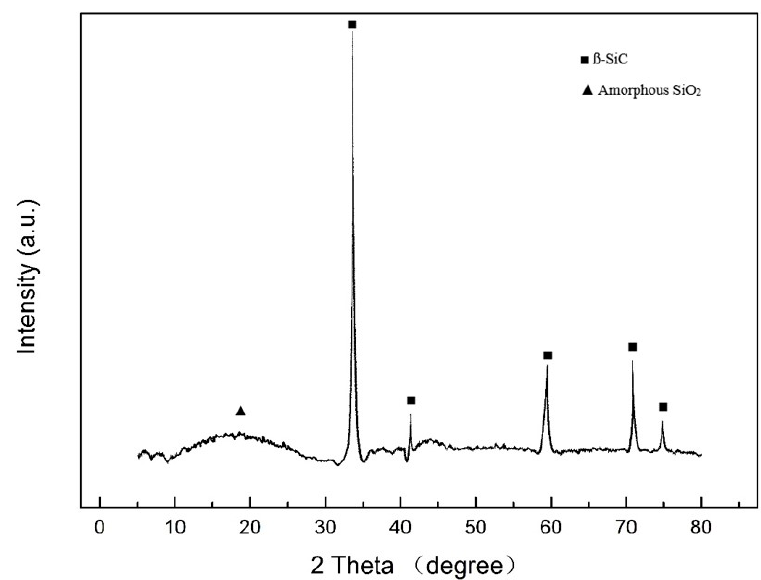
Figure 4. XRD images of SiC/SiO 2 coated CF.